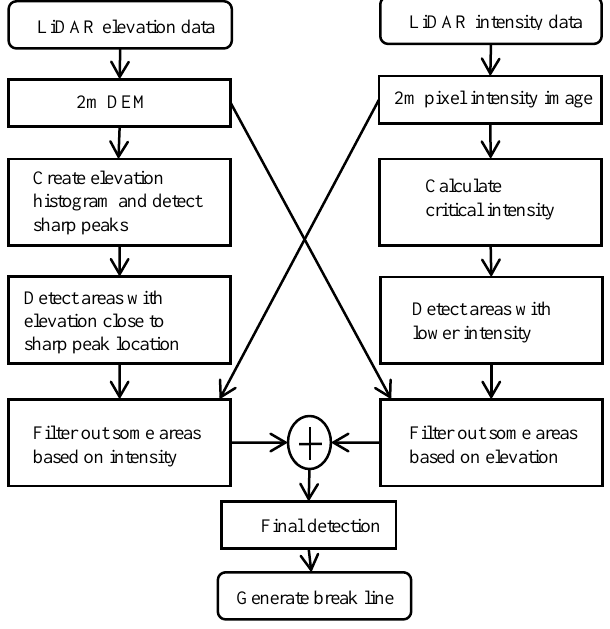
Figure 1. Flow chart for the proposed auto hydro break line generation method